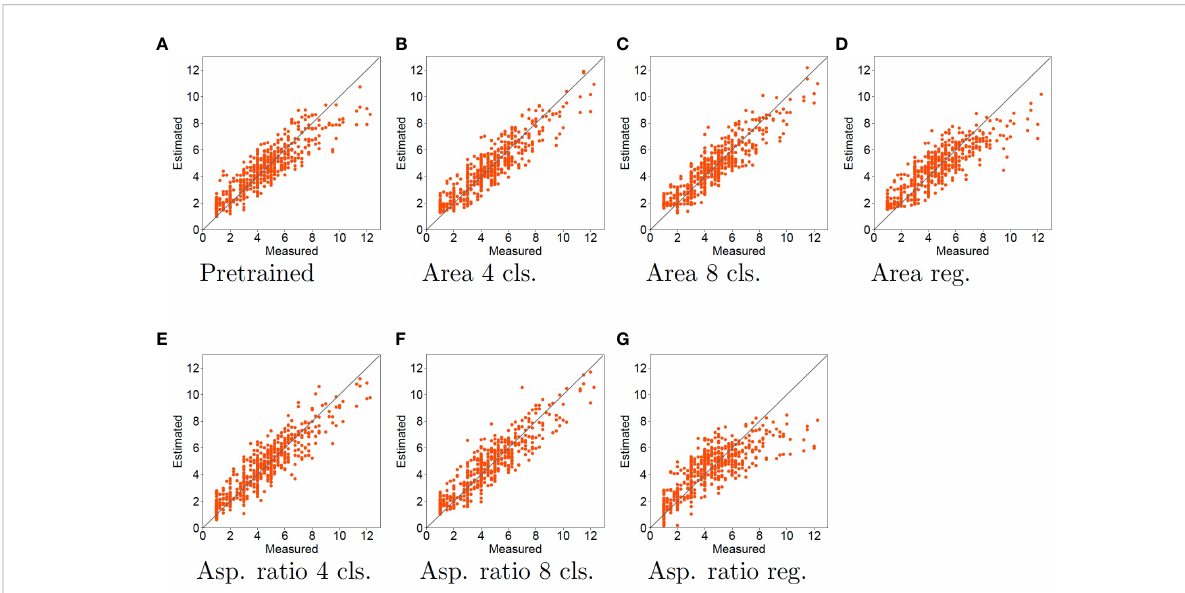
FIGURE 4 Experimental results using SVR for tiller number estimation. Horizontal and vertical axes represent the measured and estimated tiller numbers, respectively. Each red dot denotes a sample for the estimated tiller number. The black line indicates the case where the measured and estimated data match. Therefore, the closer the points are to the black line, the more accurate is the estimation.